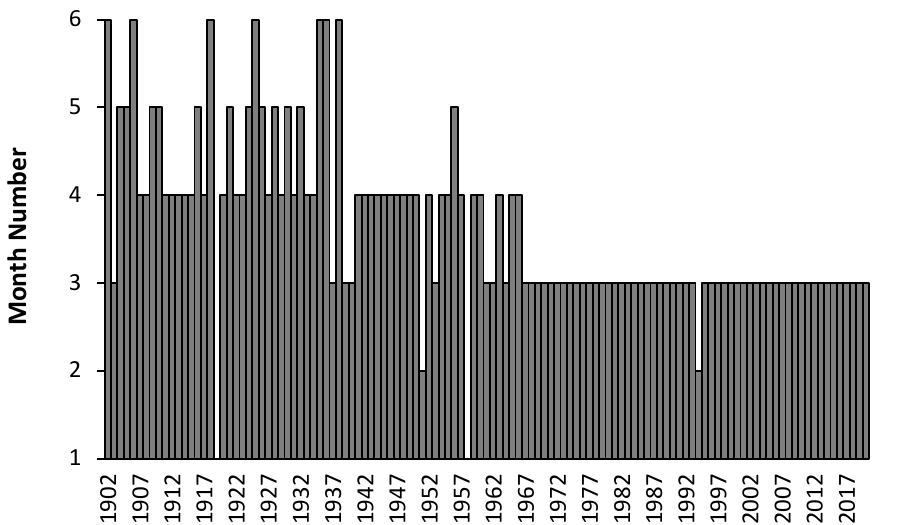
Figure 2. Month of the year at which the rolling EWM calculation reaches its maximum value in Denmark, month 1 = January, etc.